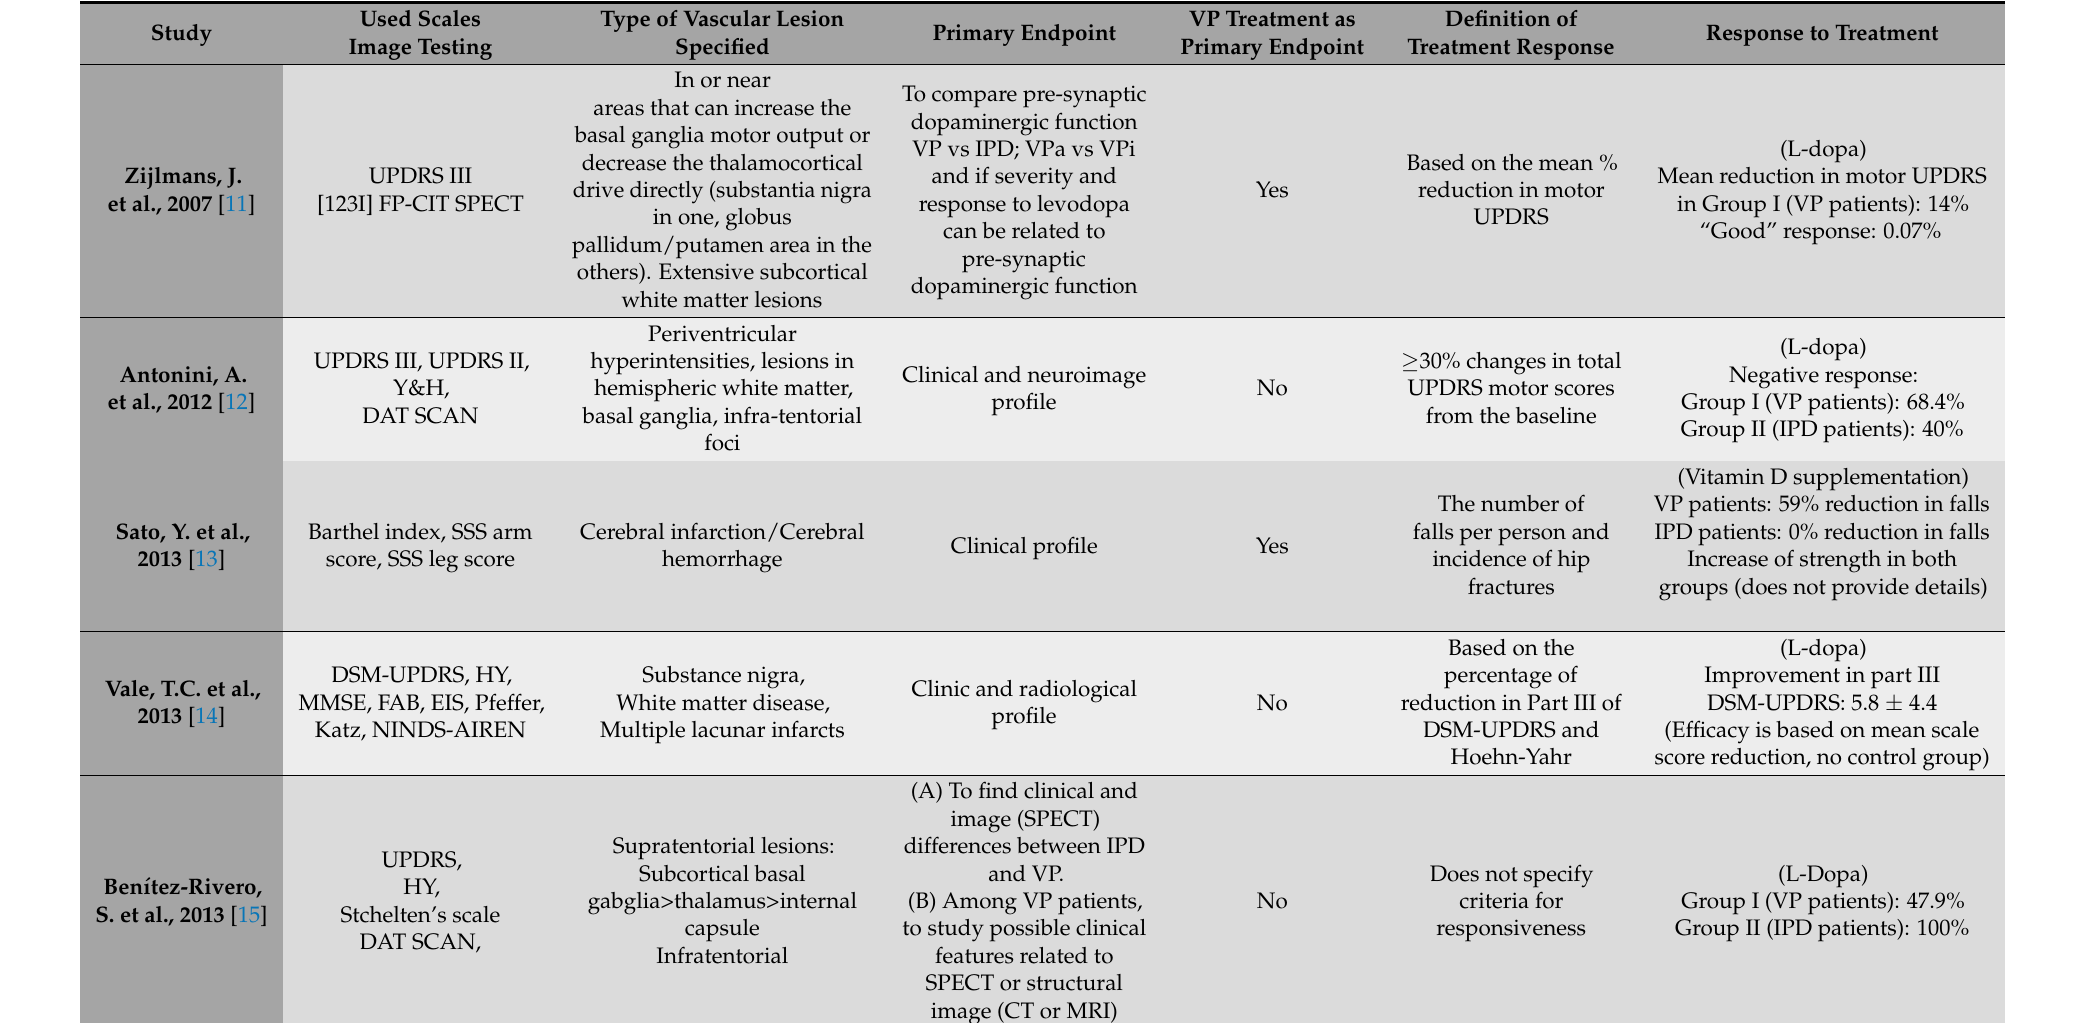
Table 2. Study methodology (continuation) and main